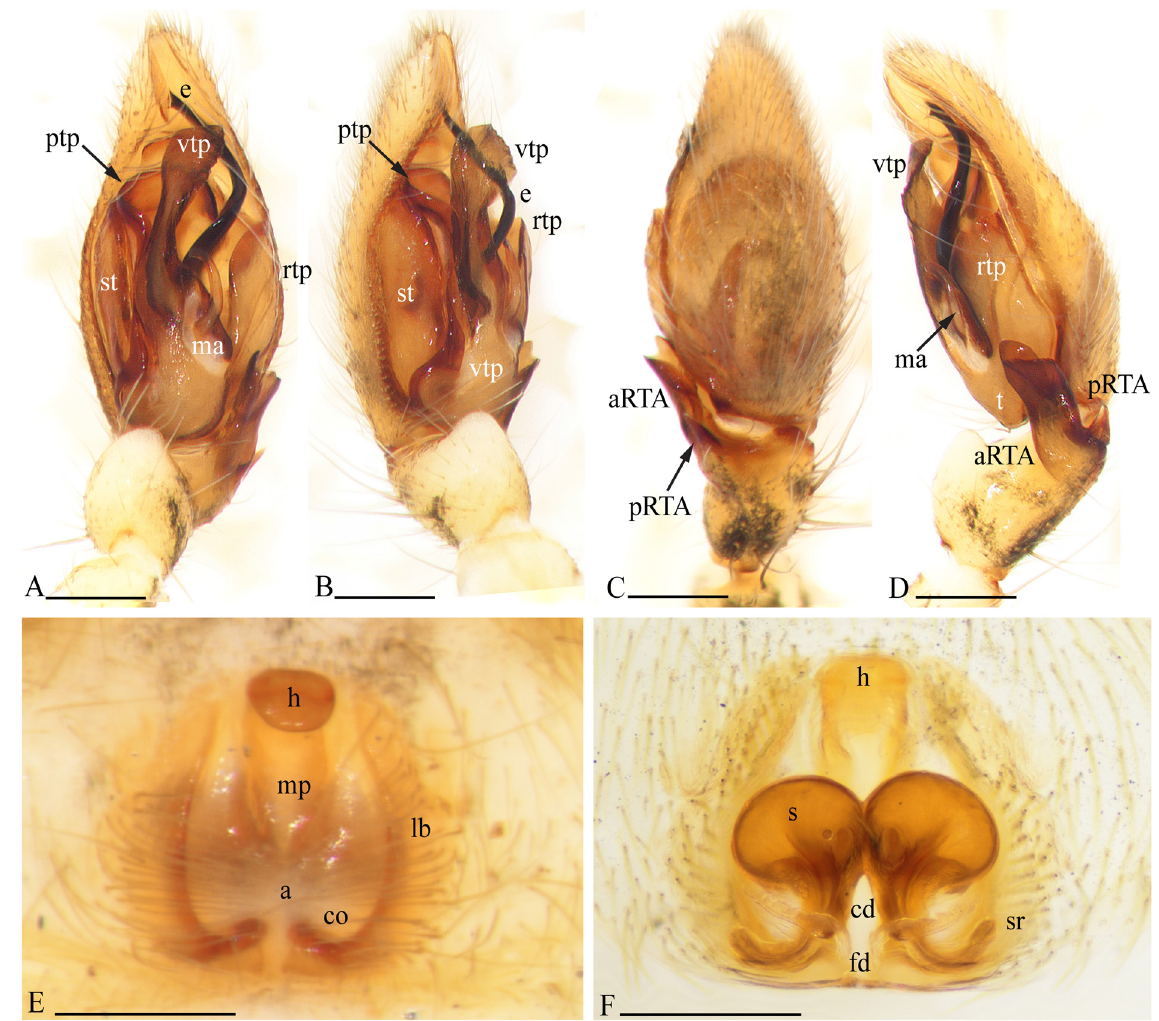
Fig. 4. Anyphaena natachae sp. nov., paratypes (CNAN-T01562). A . ♂, pedipalp, ventral view. B . ♂, pedipalp, prolateral view. C . ♂, pedipalp, dorsal view. D . ♂, pedipalp, retrolateral view. E . ♀, epigynum, ventral view. F . ♀, epigynum, dorsal view. Scale bars: 0.2